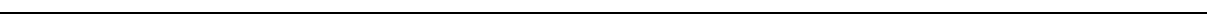
Fig. 3 Approach to identify tumour suppressors showing excess homozygous deletions. The approach is illustrated for the BIRC2/BIRC3 locus. a Assessing enrichment of homozygous deletions. The genome is segmented into bins of constant number of observed homozygous deletions by considering all start and end points of every homozygous deletion to be a breakpoint (top). Enrichment is then evaluated over a random model in which the homozygous deletions are shuf fl ed across the genome (permutation strategy 2, middle). For each bin, a p -value is calculated as n / M , where n is the number of permutations resulting in at least as many homozygous deletions in the bin as are observed, and M the total number of permutations (bottom). P -values are adjusted for multiple testing and considered signi fi cant when q ≤ 0.05. Neighbouring signi fi cant bins are merged when they lie within 1 Mb and share > 50% of the underlying homozygous deletions. Within each combined region (96 in total), the peak used for downstream analysis is de fi ned as the largest bin with maximal overlap. b Statistical model to test for local fragility. Two metrics capture the distinct structural signature of deletions in fragile sites when compared to regions harbouring tumour suppressors: ( R1 ) the ratio of homozygous to small ( ≤ 1 Mb) hemizygous deletions and ( R2 ) the ratio of large to small hemizygous deletions. Note the addition of pseudocounts to avoid zero values in the denominator. Estimated densities of these metrics for fragile sites and tumour suppressors are shown as well as the values obtained for all peaks, except those on the X chromosome (named fragile sites, blue; known tumour suppressors, red; unknown, grey; BIRC2/BIRC3 large red bar). P -values for all peaks are computed under the fragile site null model density. Tumour- type speci fi city is the third pillar of the model and is tested in a 2 × 2 table of homozygous vs. small hemizygous deletions in the tumour type with the most deletions vs. the other tumour types combined. P -values from the three tests are combined and adjusted for multiple comparisons. Local fragility is rejected and the presence of a tumour suppressor considered for peaks with q ≤